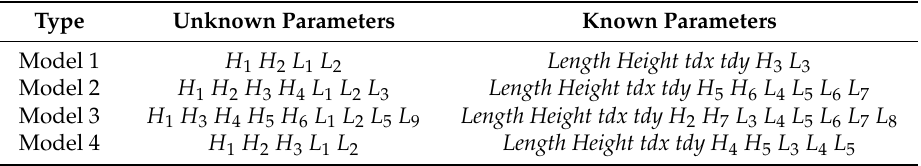
Table 1. Parameters of different types.